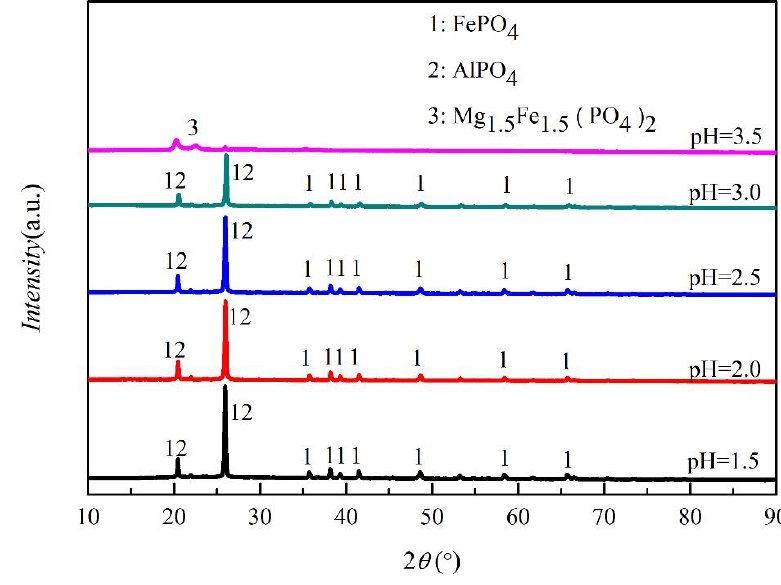
Figure 7. XRD pattern of the sample at di ff erent pH values.